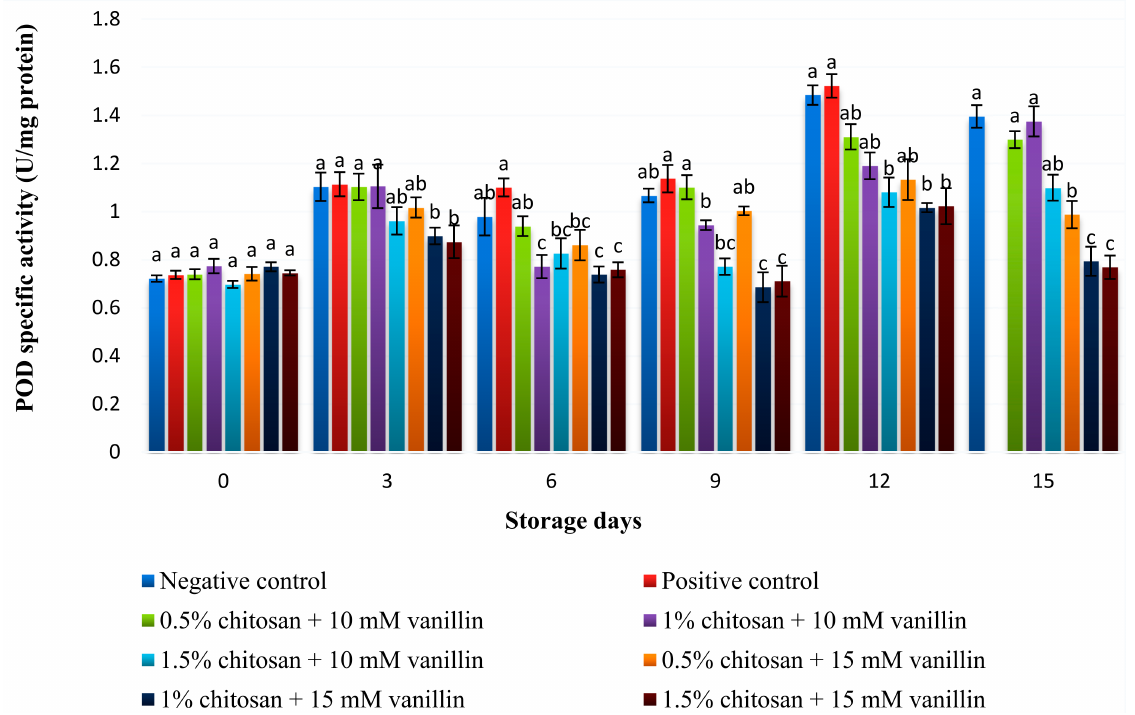
Figure 10. Effects of coating treatment on POD specific activity in Fusarium oxysporum inoculated tomato fruit stored for 15 days at 26 ± 2 ◦ C and 60 ± 5% relative humidity. Mean values in a column followed by different letters for each storage day differed significantly by LSD at p ≤ 0.05. Vertical bars indicate standard error of means ( n =